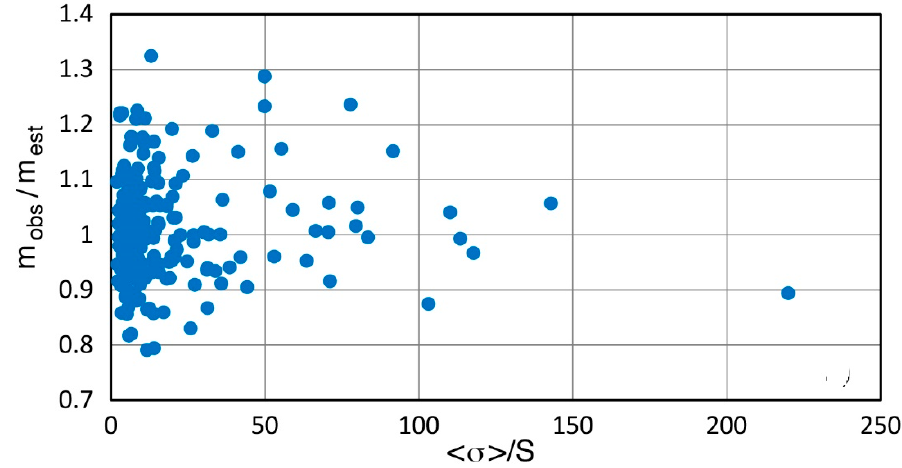
/ m < σ >/ S for the whole datasets. est (blue dot) vs.